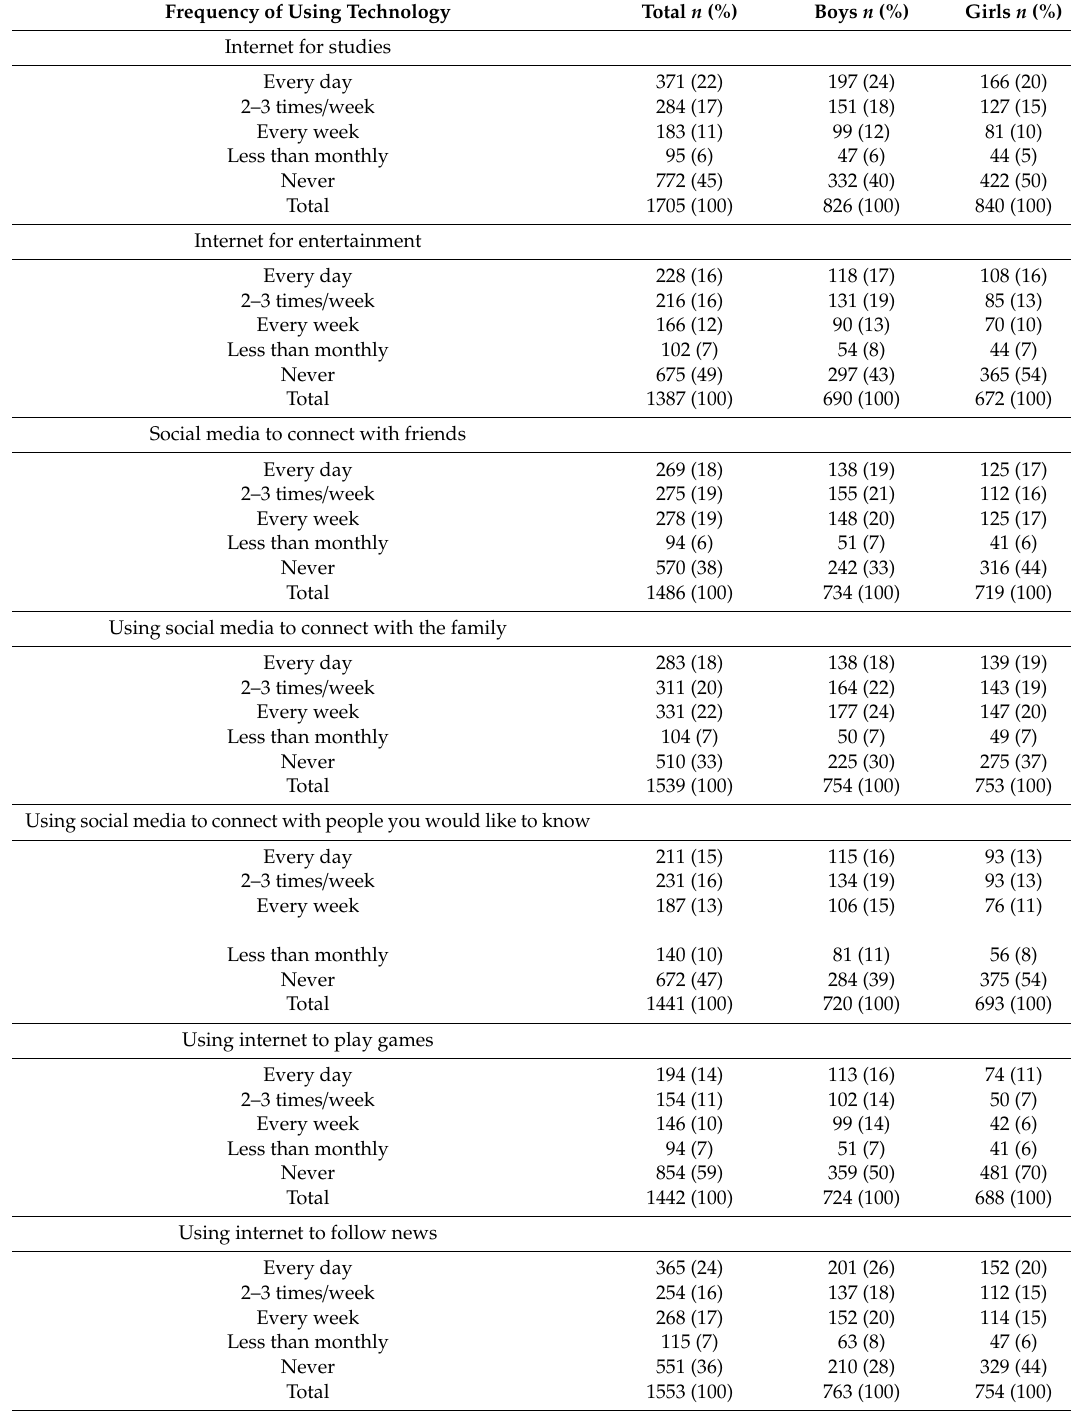
Table 4. Participants’ frequency of usage of di ff erent tools of digital technology, by gender. Adolescents attending schools in Bissau, June